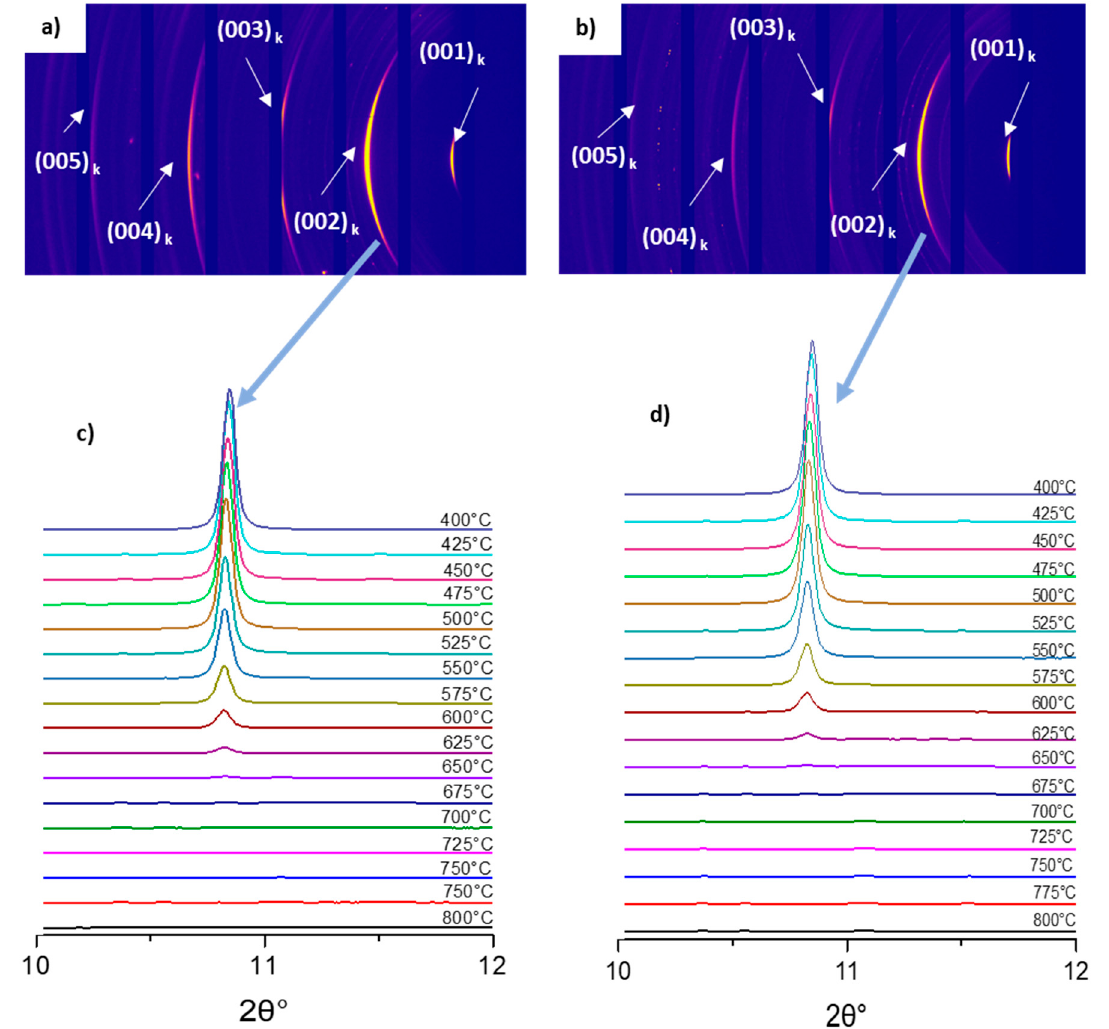
Figure 7. ( a , b ) Debye–Scherrer diffraction rings recorded at room temperature under an incidence angle equal to the (002) planes Bragg angle, for KCS100 and KRG50H50, respectively. ( c , d )